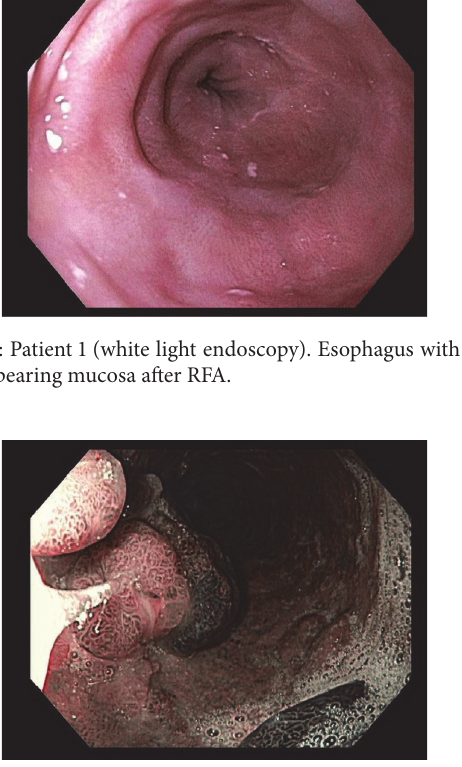
Figure4:Patient2.OriginalEGD(NBI).Severalshort-stalkedpoly- poid lesions in the